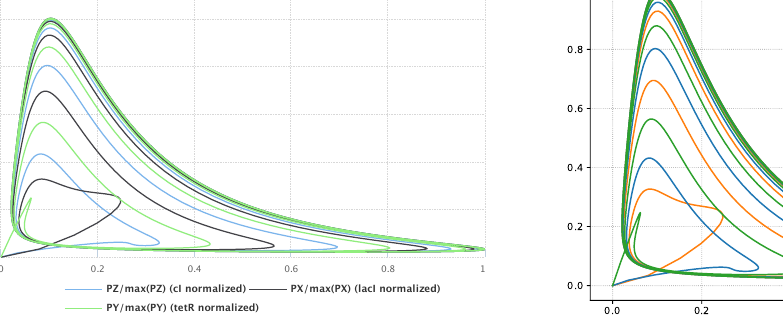
Figure 1.6: Time-course simulation of the repressilator. Normalized lacI , tetR and cI in phase-plane. Simulation with tellurium